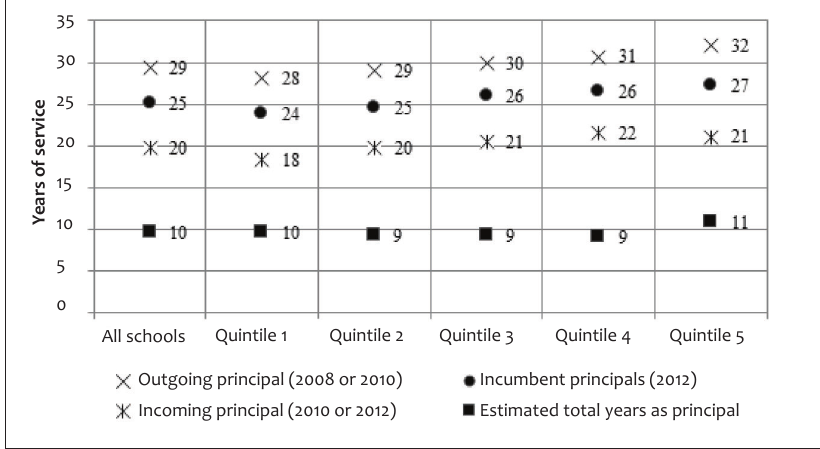
Figure 5: Average years of service of outgoing, newly appointed and all incumbent